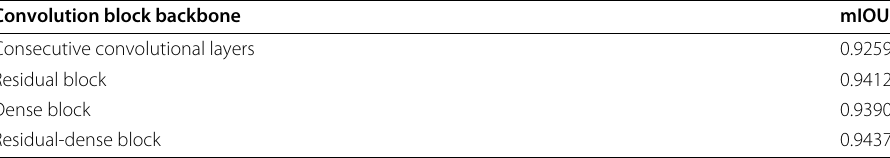
Table 2 mIOU of the U-shape models with different convolution block